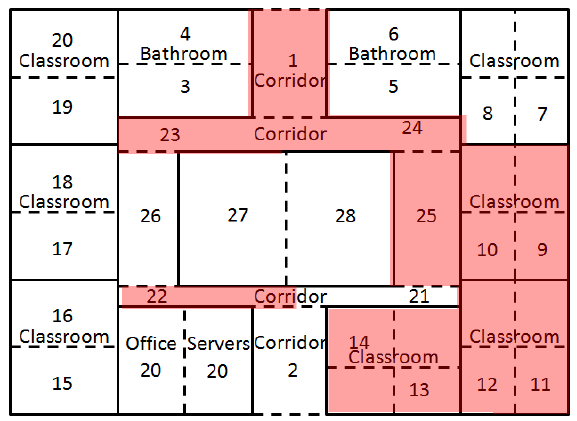
Figure 3. Distribution plane of main floor of school building used to comprise the magnetic field data set.